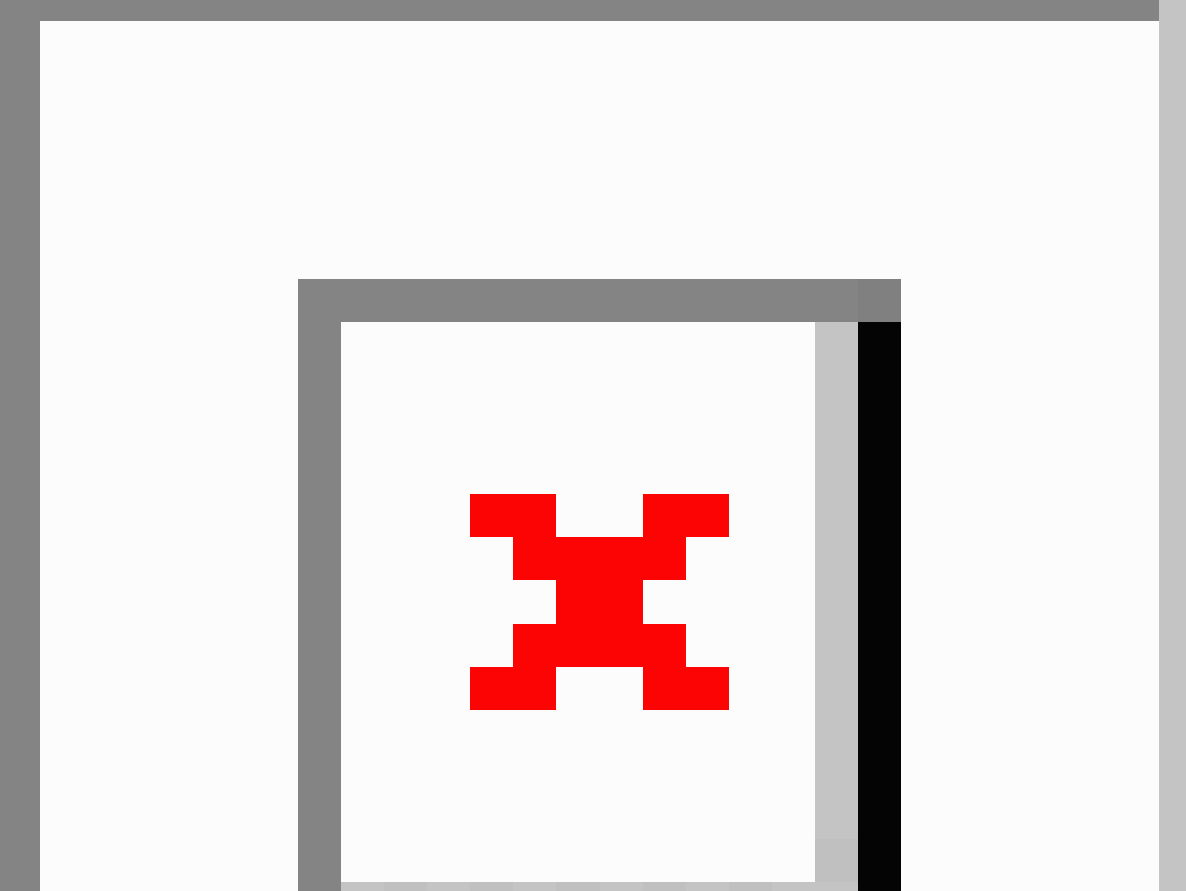
Figure 3. Geographic information system (GIS) maps demonstrating the diabetic patient distribution for (a) type 1 diabetes and (b) type 2 diabetes at the country level, and (c) the distribution of different age groups in all health